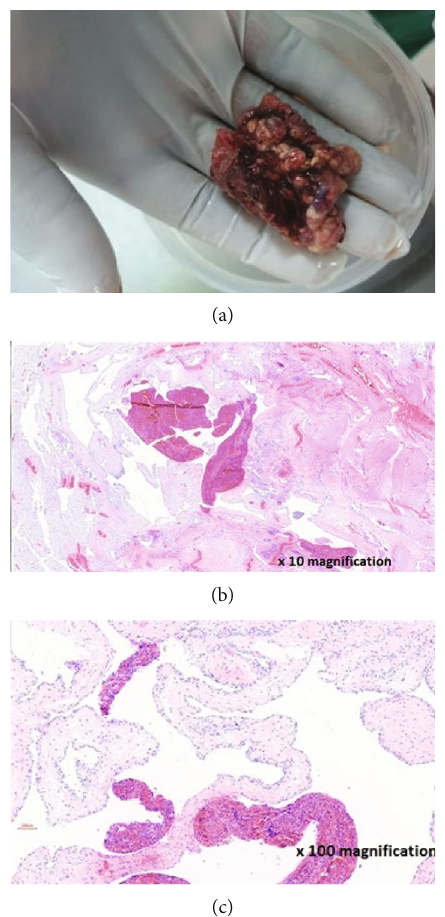
Figure 3: (a) Excised lesion; (b, c) H & E stained sections of the neck mass showing large, irregularly formed vascular spaces which are lined by fl attened, bland epithelial cells embedded within a fi brous